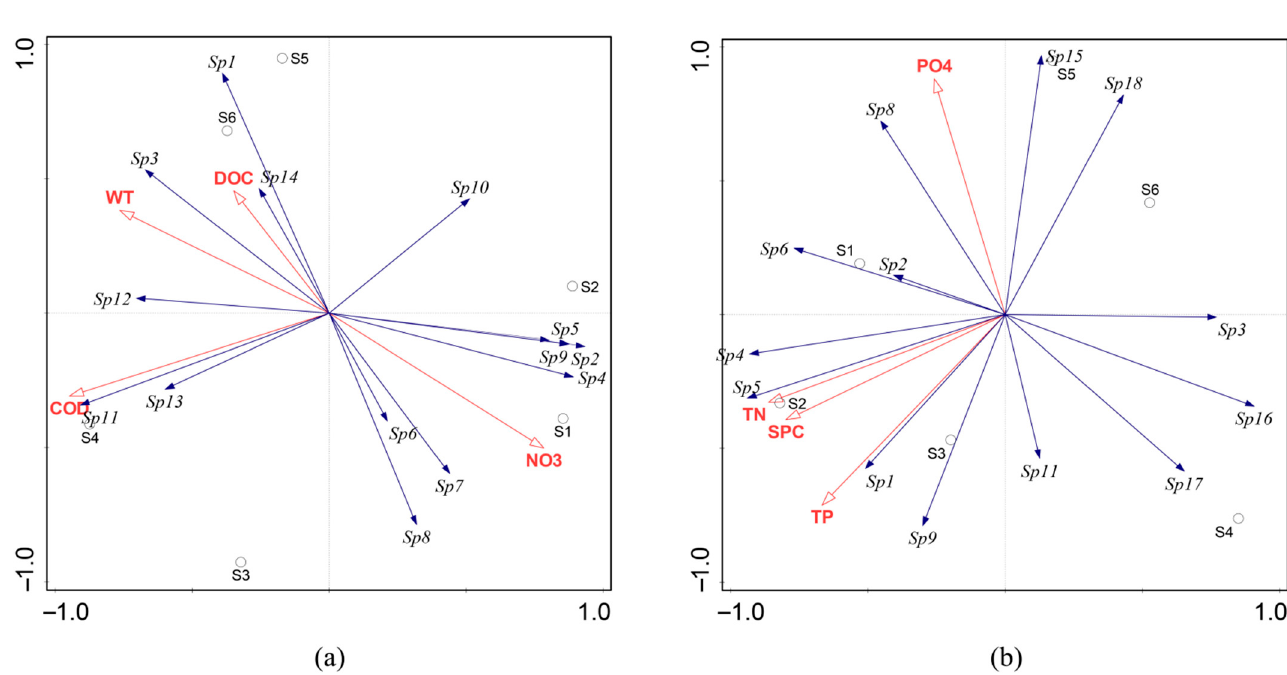
Figure 6. RDA analysis of periphytic algae and environmental factors in summer ( a ) and winter ( b